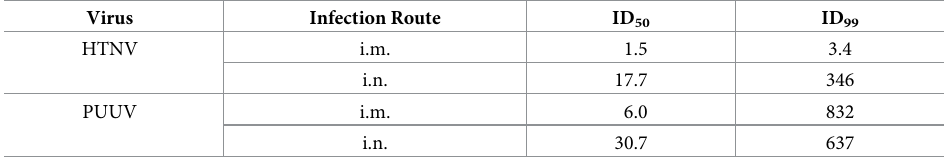
Table 1. ID 50 and ID 99 for HTNV and